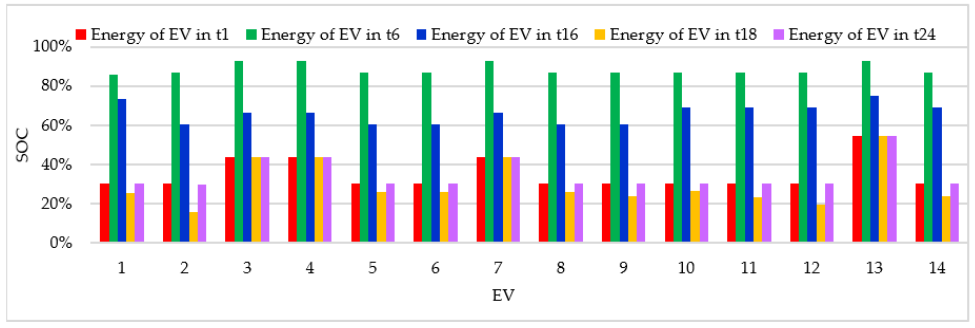
Figure 6. SOCs for the first 14 EVs, charging on a weekday.